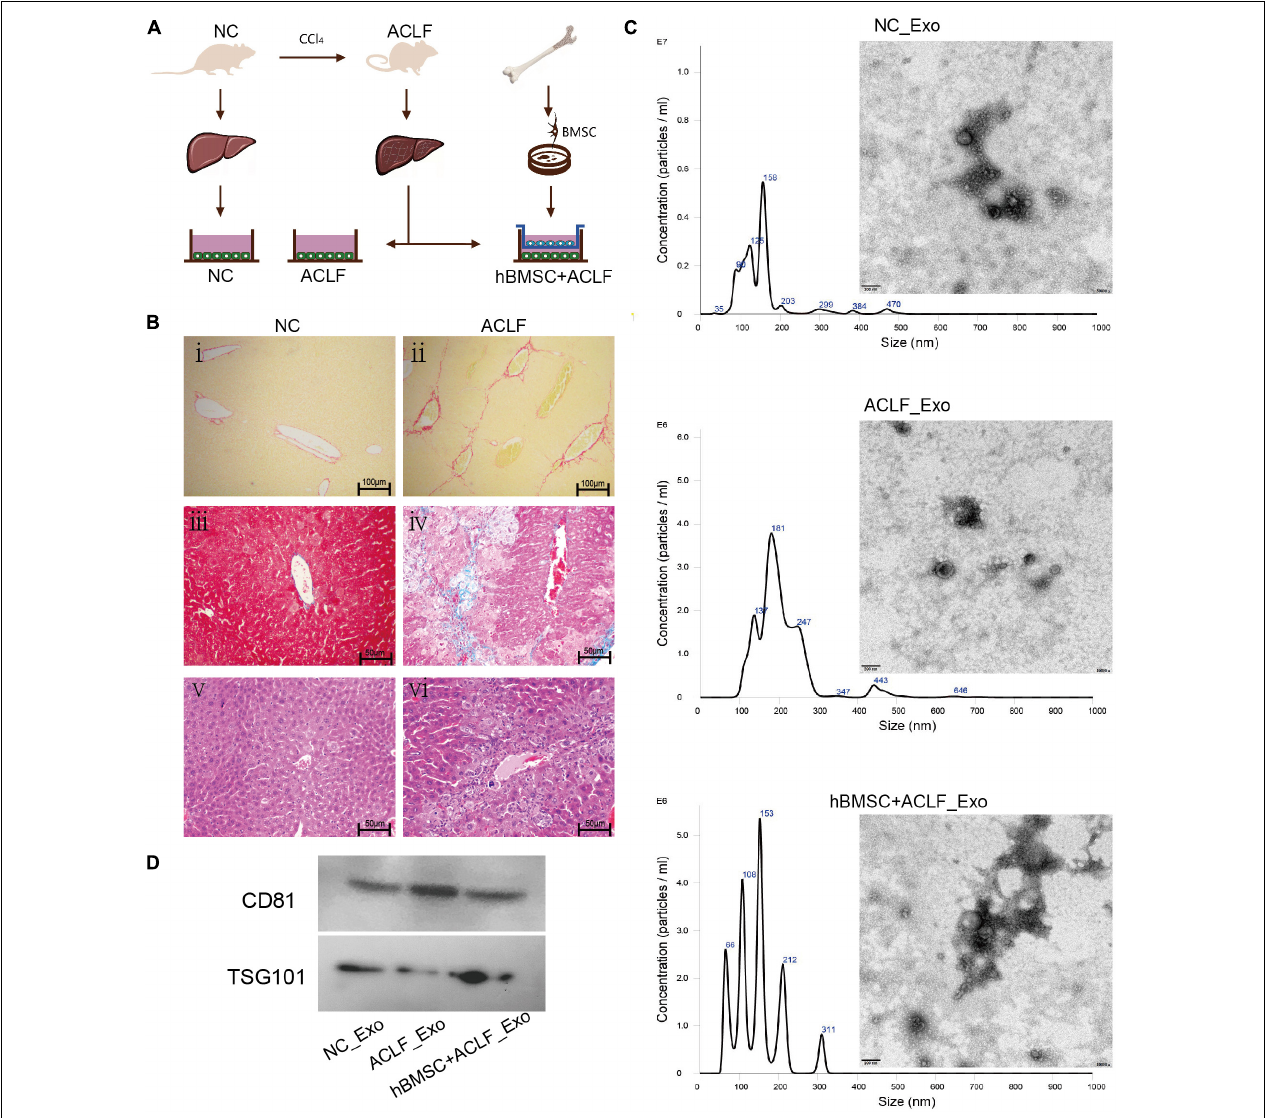
FIGURE 1 | Characterization of the ACLF model and the derived exosomes. (A) ACLF was induced in mice using carbon tetrachloride, and then primary hepatocytes were isolated and cultured in vitro , in the absence or presence of MSCs. Cells from healthy animals were collected as controls. The supernatants of the three groups of cells were then collected for exosome extraction. (B) Sirius red staining (i-ii, scale bar = 100 µ m), Masson’s trichrome staining (iii–iv, scale bar = 50 µ m) and H&E staining (v–vi, scale bar = 50 µ m) reveal significant fibrosis, collagen deposition, and inflammatory cell infiltration and necrosis, respectively, in the livers of ACLF mice. (C) NTA and TEM-based analyses of exosomes reveal that the particles are concentrated in the 200-nm range and have a cup-like bilayer structure. (D) Western blotting reveals the expression of the exosome membrane marker CD81 and of the intra-particle marker TSG101.